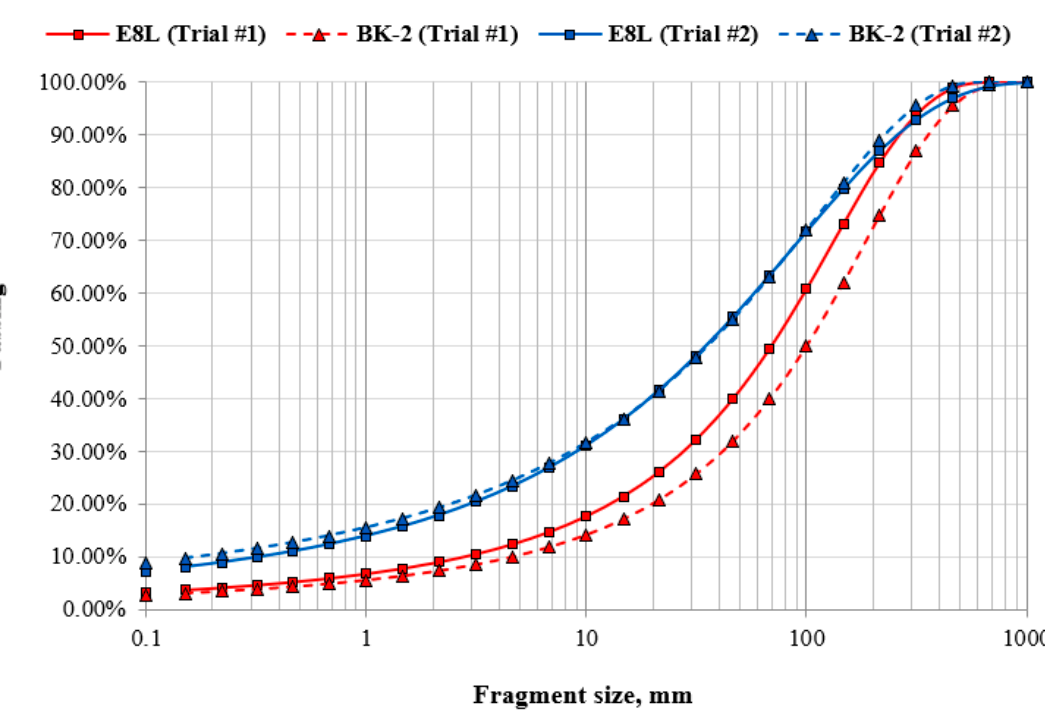
Figure 12. Comparison of Swebrec models for both trials.